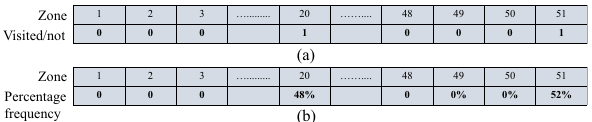
Figure 3: How ( a ) ASA and ( b ) QASA records data for analysis is shown. Here in ( a ) , 1 and 0 represent whether the corresponding zone is visited or not